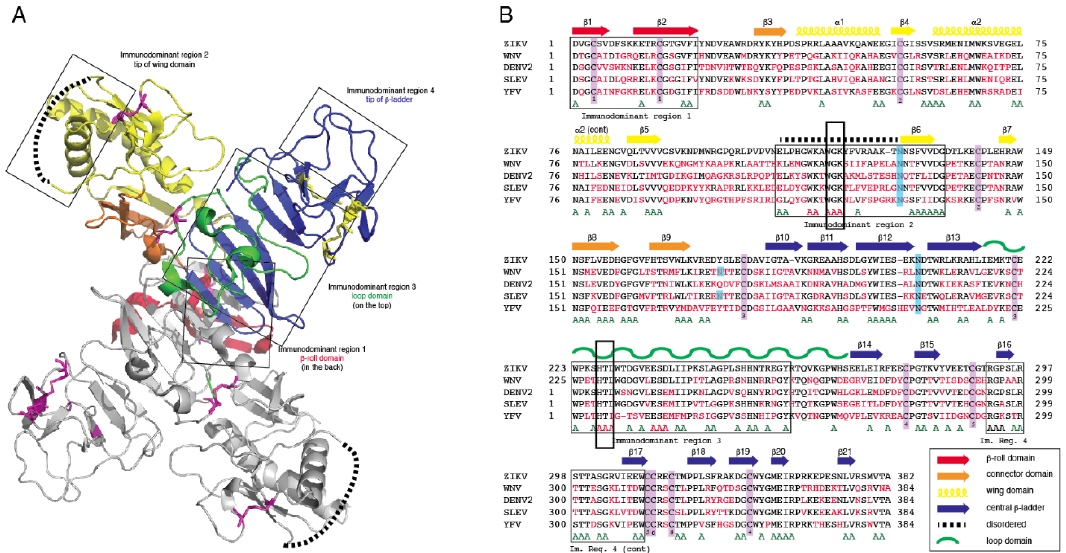
Figure 1. Comparison of non-structural protein 1 sequences among closely related flaviviruses. ( A ): Ribbon model high- lighting regions of the NS1 protein containing segments exposed at the outer surface to the host environment. ( B ): Sequence comparison showing regions with high sequence disparity. Amino acids depicted in red differ from the corresponding ZIKV NS1 amino acids. A represents positions with two sequences with amino acids identical to ZIKV NS1. The boxes highlight highly conserved sequences, amino acids 117–119 and 227–229, that were mutated to alanine in immunodominant regions 2 and 3.